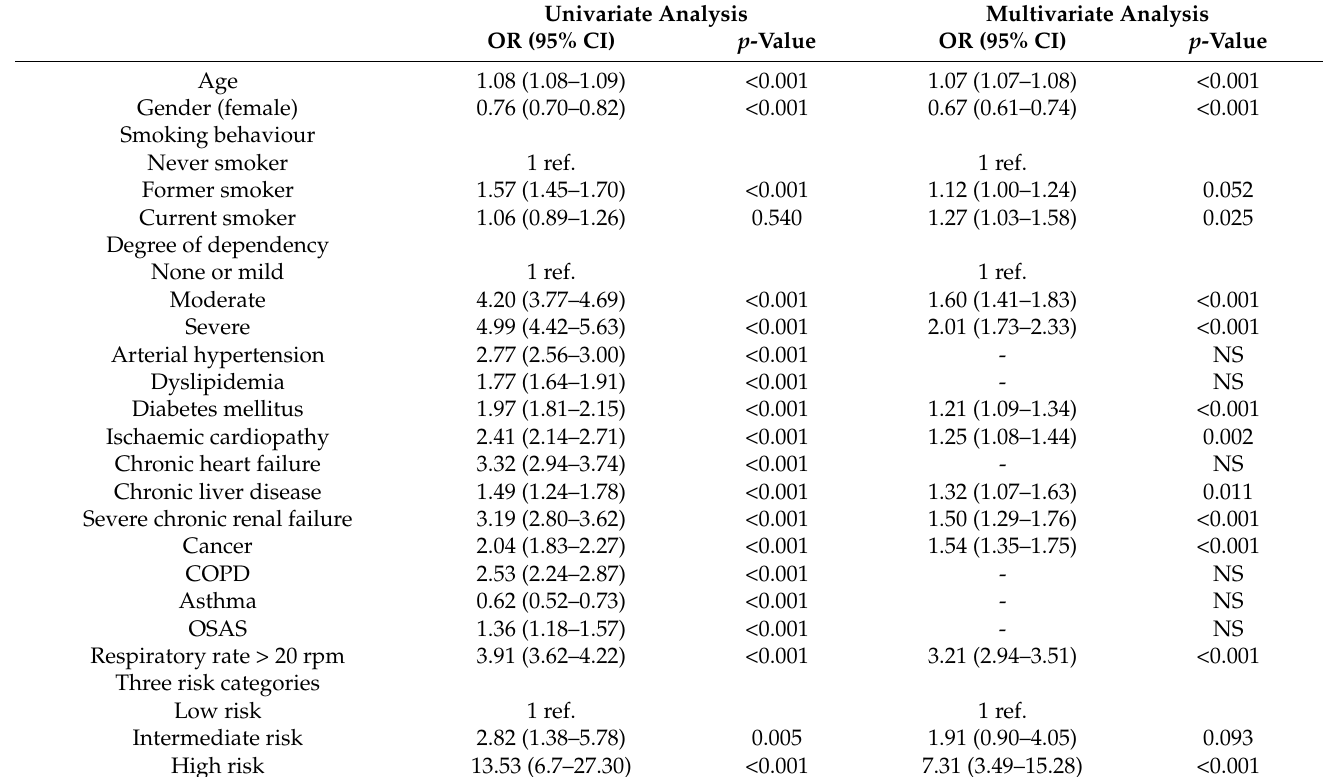
Table 6. Risk factors of in-hospital mortality. Univariate Analysis Multivariate